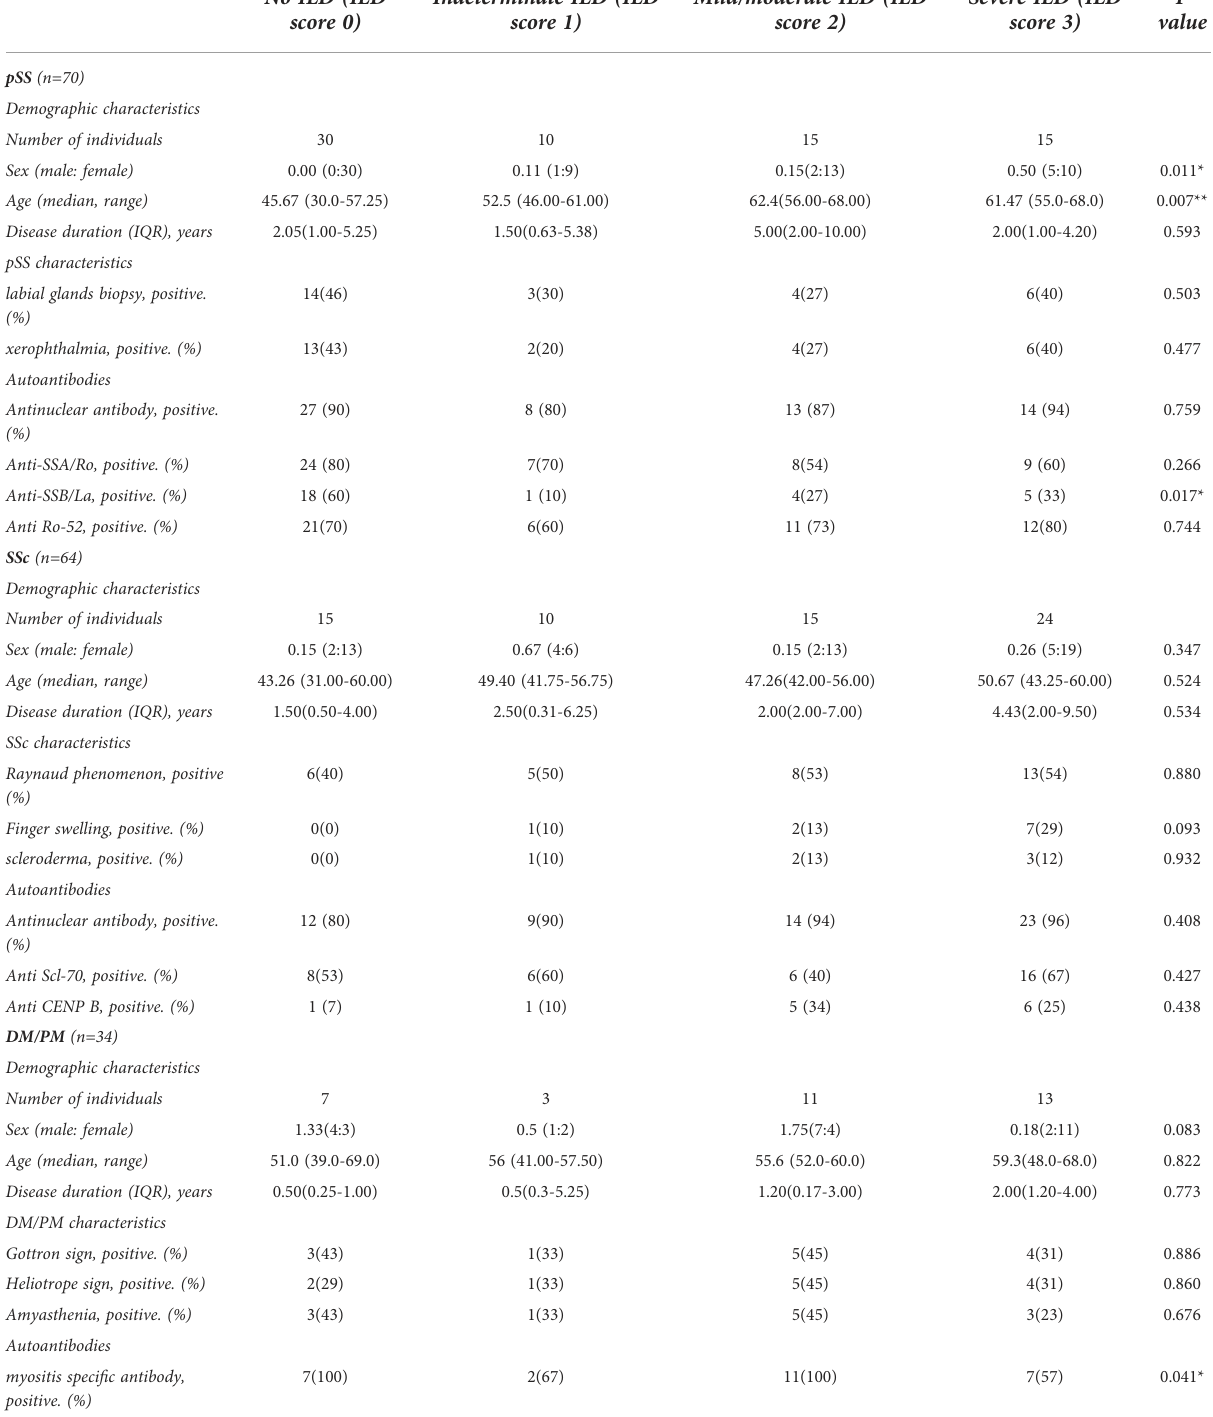
TABLE 1 Characteristics of the CTD patients with different ILD